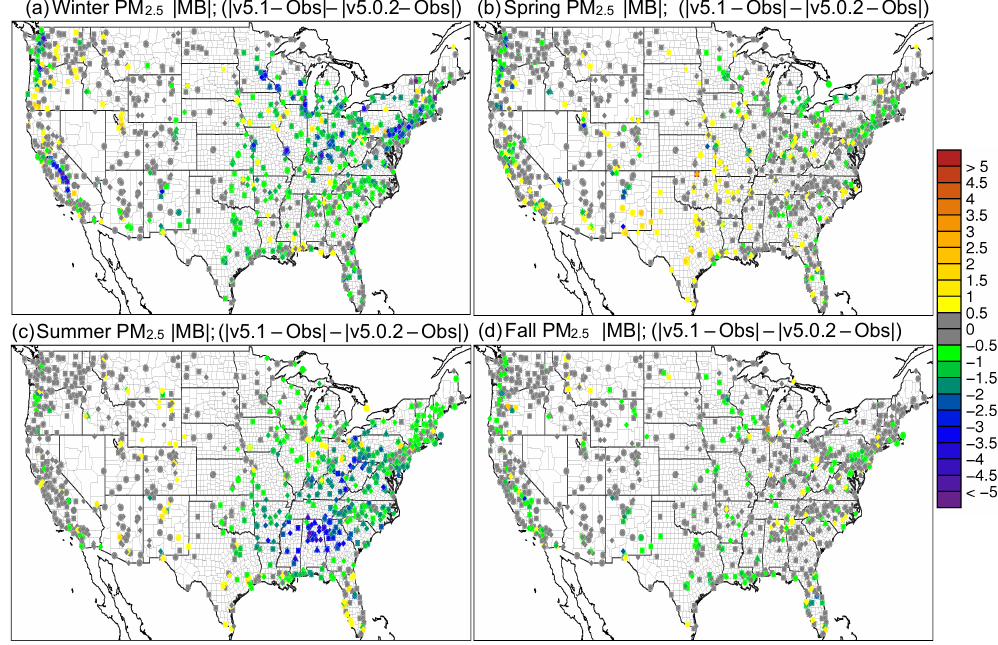
Figure 8: Difference in the absolute value of seasonal average PM 2.5 mean bias for a) winter (DJF) b) spring (MAM) c) summer (JJA) and d) fall (SON) between CMAQ v5.0.2_Base and v5.1_Base (CMAQv5.1_Base – CMAQv5.0.2_Base). All plots are in units of µgm -3 . Cool colors indicate a reduction in Figure 8. Difference in the absolute value of seasonal average PM 2 . 5 mean bias for (a) winter (DJF), (b) spring (MAM), (c) summer (JJA) PM 2.5 mean bias in v5.1 while warm color indicate an increase in PM 2.5 mean bias v5.1. and (d) fall (SON) between CMAQ v5.0.2_Base and v5.1_Base_NEIv1 (CMAQv5.1_Base_NEIv1–CMAQv5.0.2_Base). All plots are in units of micrograms per cubic meter (µgm − 3 ). Cool colors indicate a reduction in PM 2 . 5 mean bias in v5.1, while warm colors indicate an increase in PM 2 . 5 mean bias